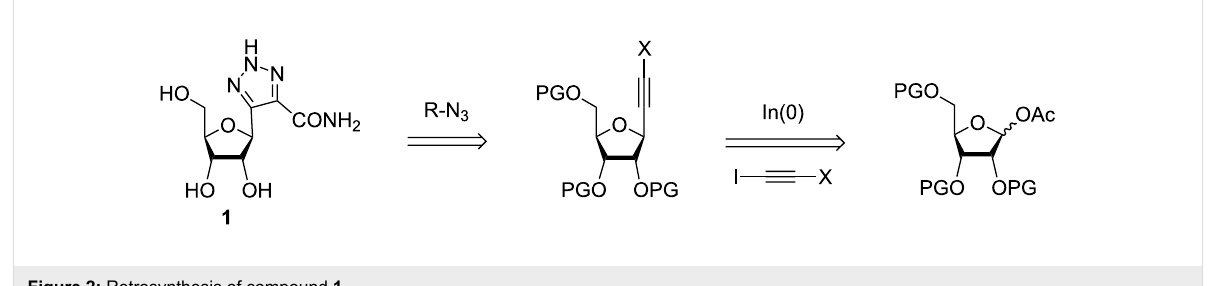
Figure 2: Retrosynthesis of compound 1